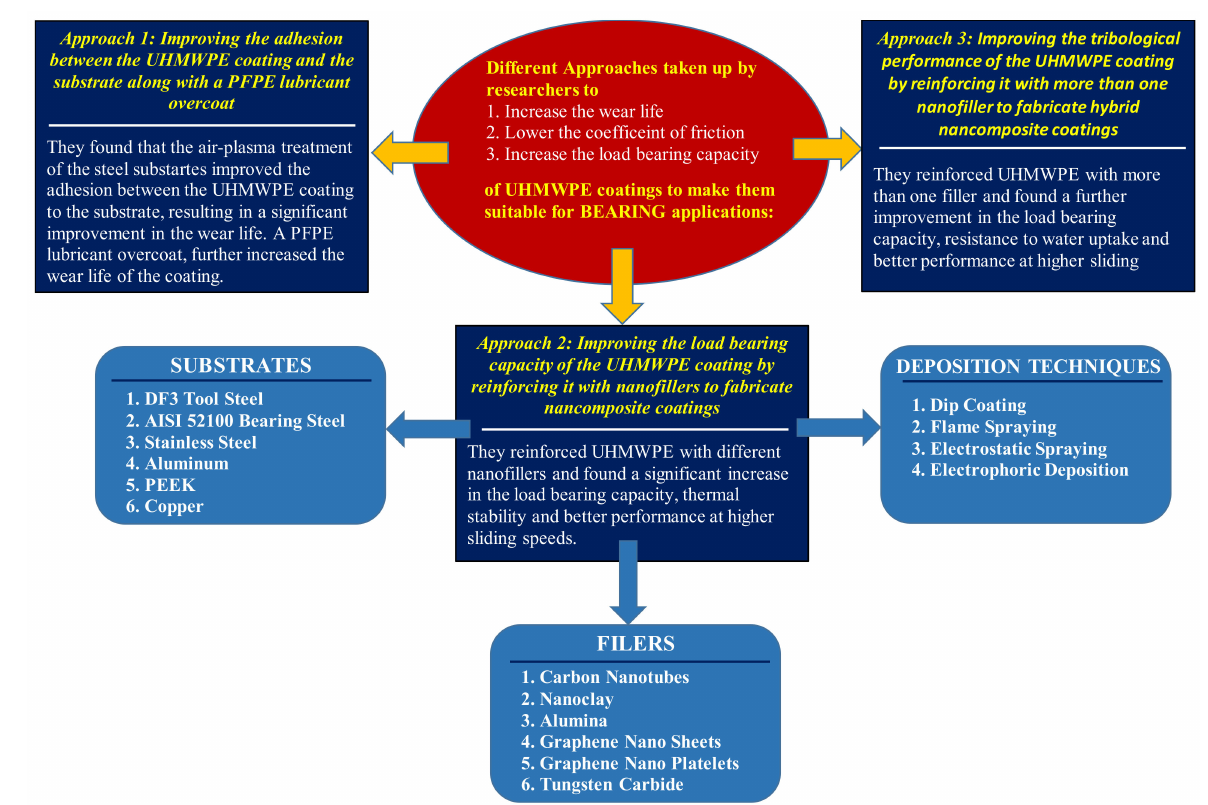
Figure 12. Schematic of the different approaches used by researchers to make the UHMWPE coatings suitable for demanding tribological applications such as Mechanical Bearings. It also lists out the different substrates, nanofillers and the deposition techniques used for fabricating the nanocomposite